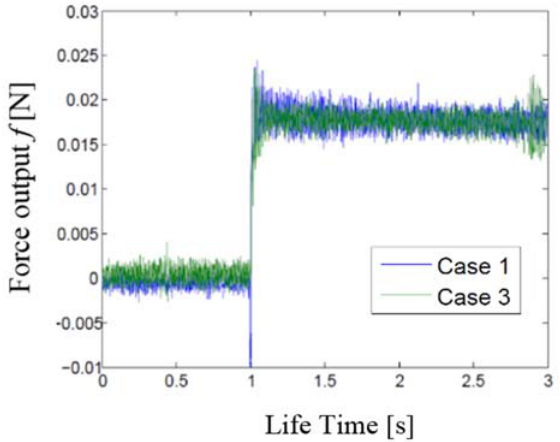
Figure 7. Comparing static force output in isometric loading with that from a step input voltage: RP-DEA with single AR and RP-DEA with multiple ARs.